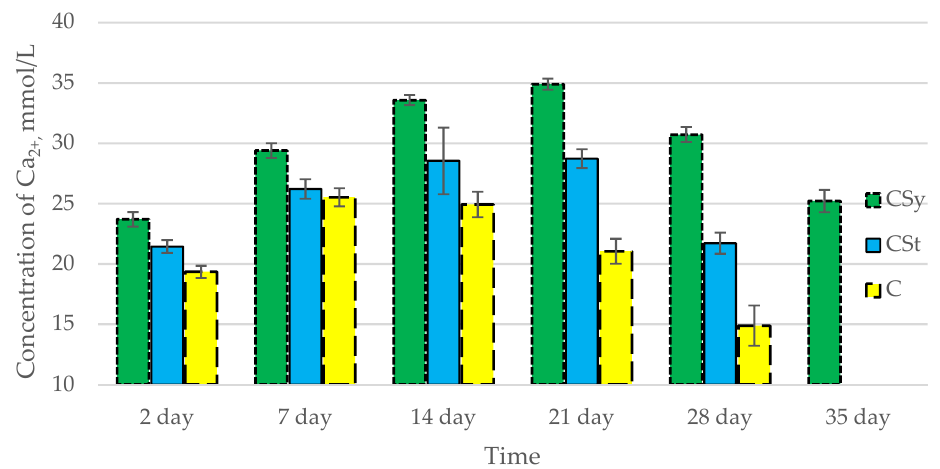
Figure 6. Calcium concentrations in the 2-, 7-, 14-, 21-, 28-, 35-day-old honey bees’ hemolymph